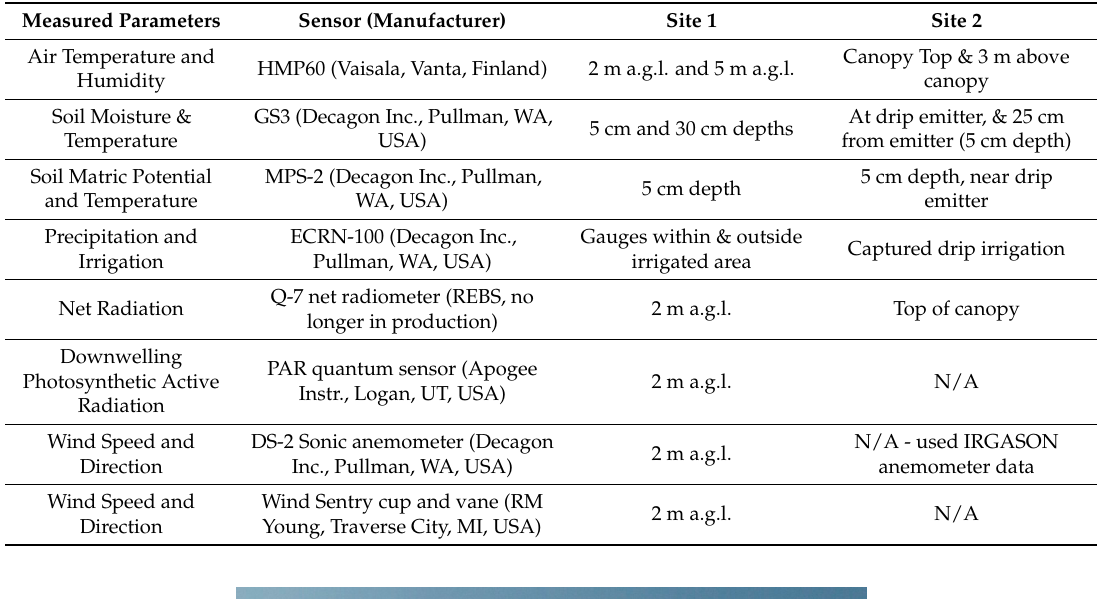
Table 1. Description of low-cost sensors used in the on-farm experiments.